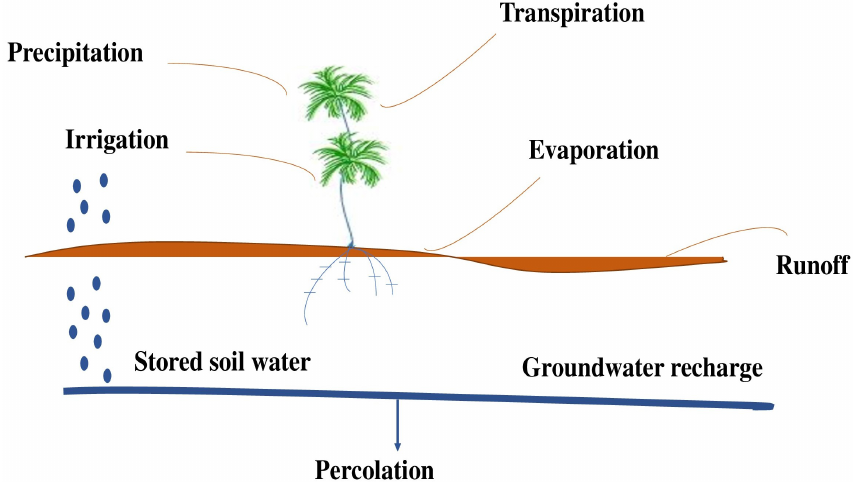
Figure 5. Illustration of the various water transport components needed to characterize irrigation